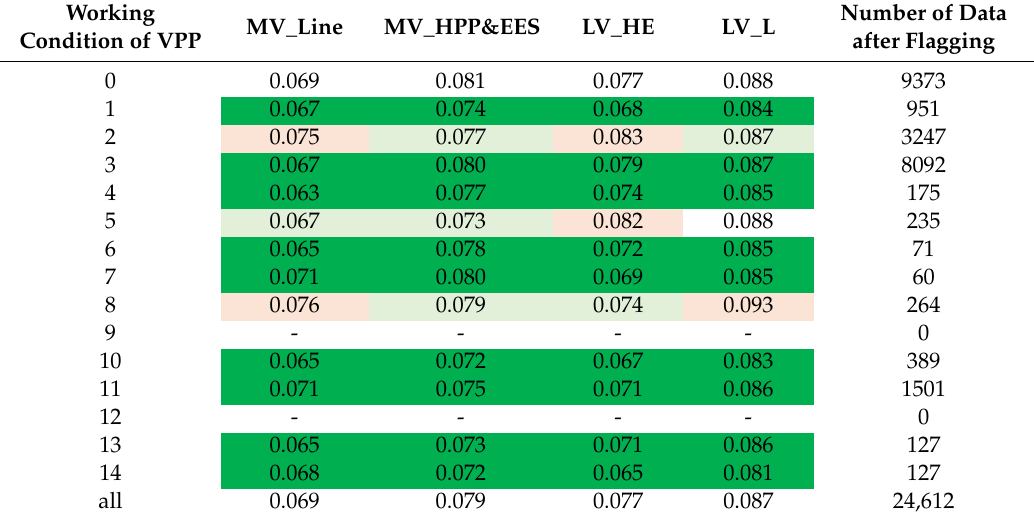
Table 8. Impact of flagging concept for area-related